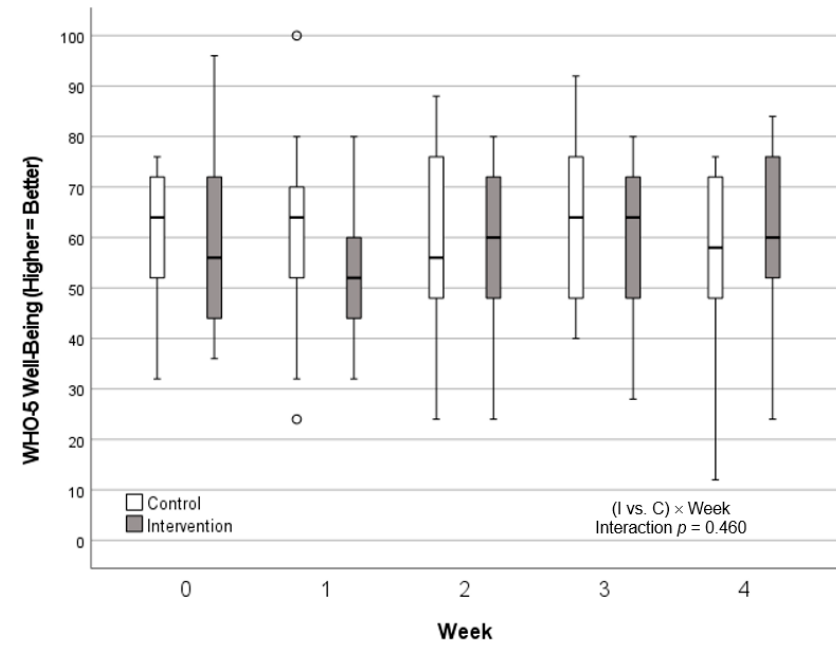
Figure 4. WHO Well-Being Index scores over time by group.